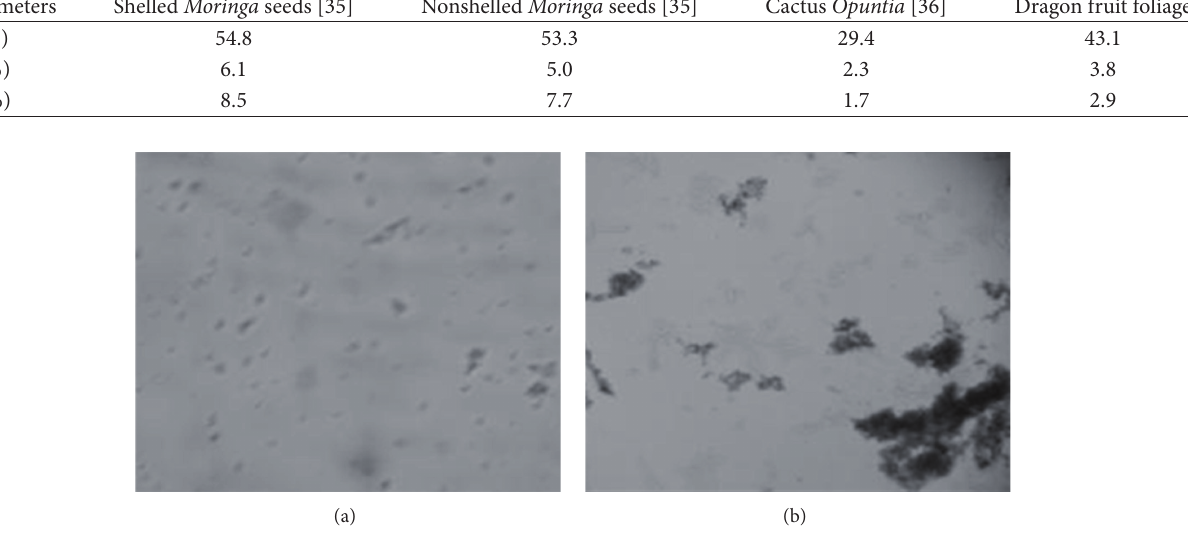
F 2: Floccules (a) before and (b) aer the coagulation process of concentrated latex effluent.